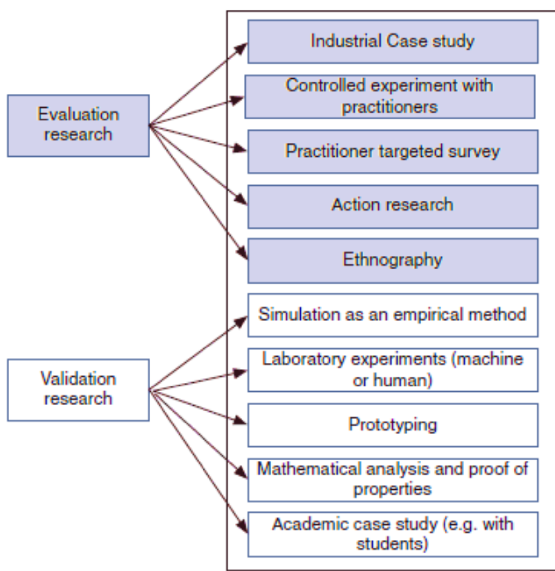
Figure 2. Classification of research